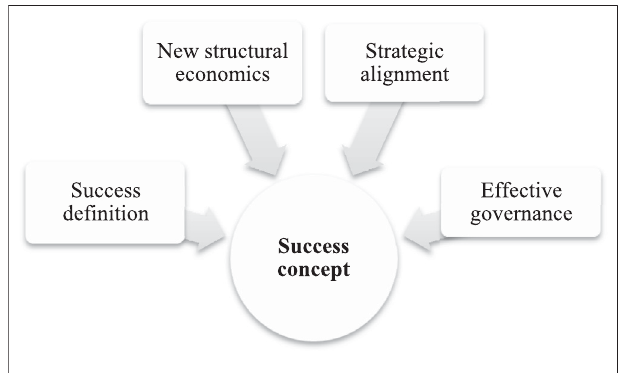
FIGURE 3 | Elements for improving project